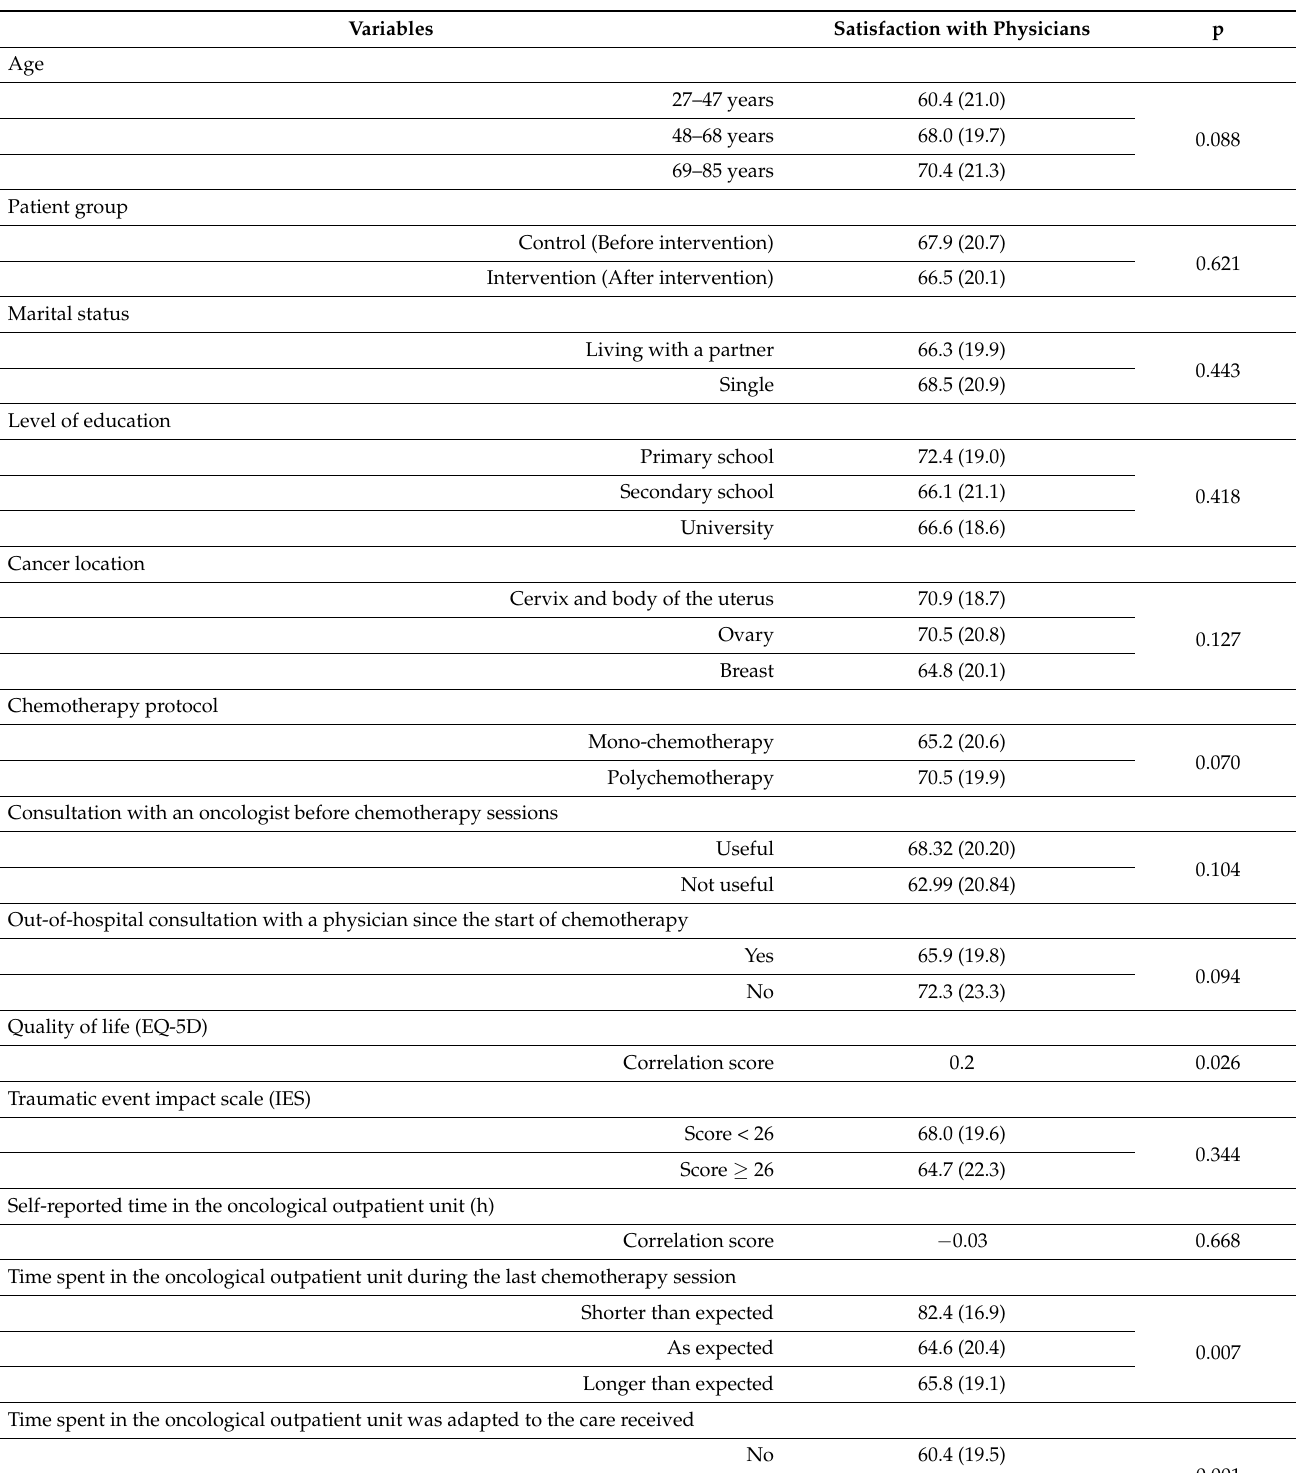
Table 2. Factors associated with score of satisfaction with physicians—univariate